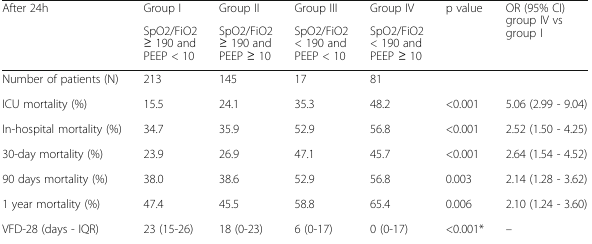
Table 7 (abstract A5). Distribution and Outcomes after 24 hours After24h Group I Group II Group